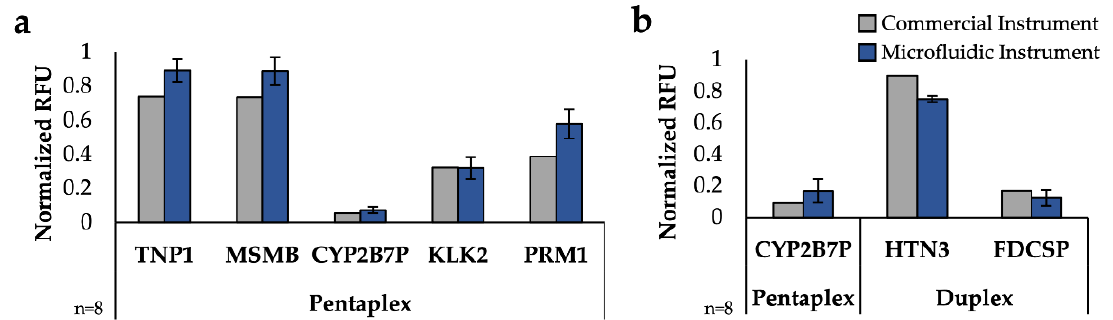
Figure 5. Multi-source fluid comparison of peak heights from gold-standard CE systems and the microfluidic system. ( a ) Electrophoresis of contrived mixed sample containing vaginal fluid and semen amplified with the Pentaplex panel of primers. ( b ) Normalized peak heights from a mixed sample containing vaginal fluid and saliva amplified with the Pentaplex and Duplex